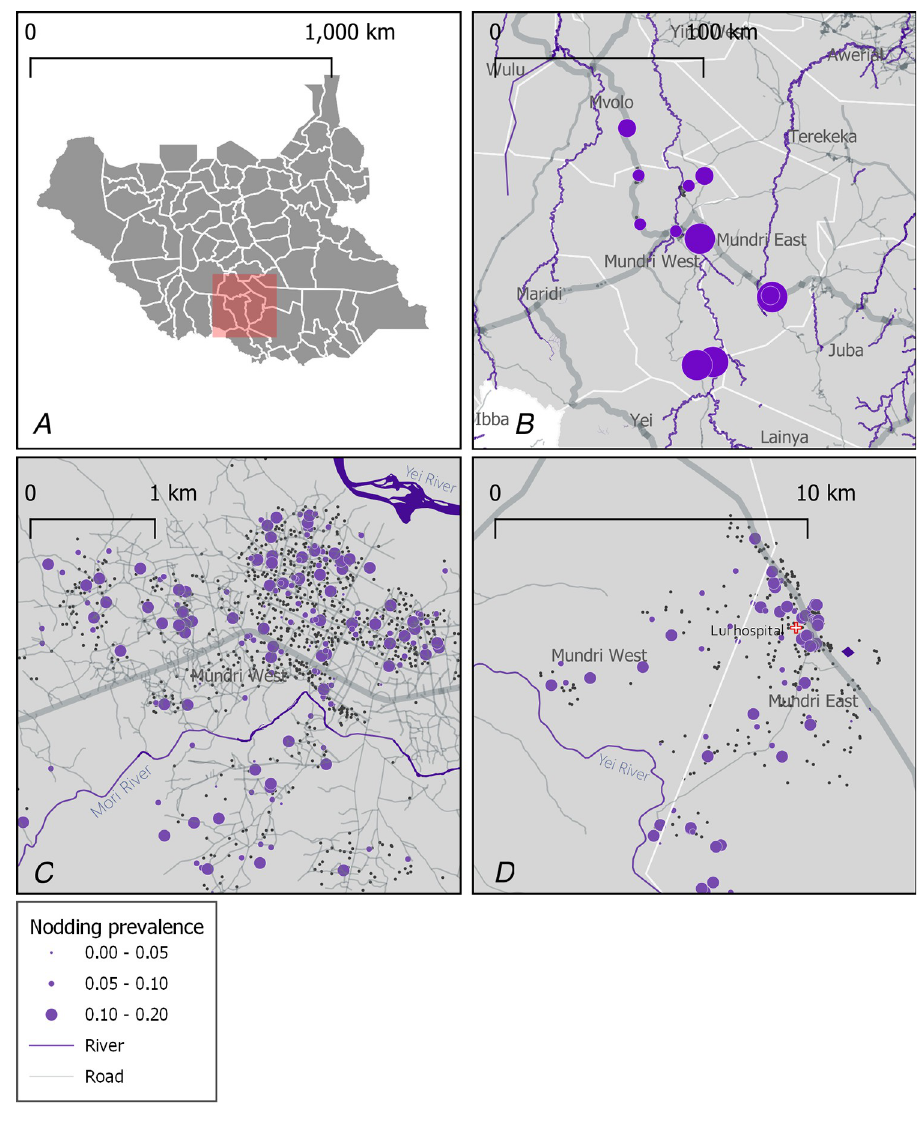
Fig 1. Spatial distribution of NS in the Greater Mundri Area, South Sudan. General location of the study site (A), NS prevalence across boma in the study area (B), and (C) distribution of NS affected households in Mundri (C) and Lui (D) villages. The administrative boundaries were contributed by UNOCHA South Sudan: https://data.humdata. org/organization/6d0c317d-5075-41d8-9dab-568edbb3d409.